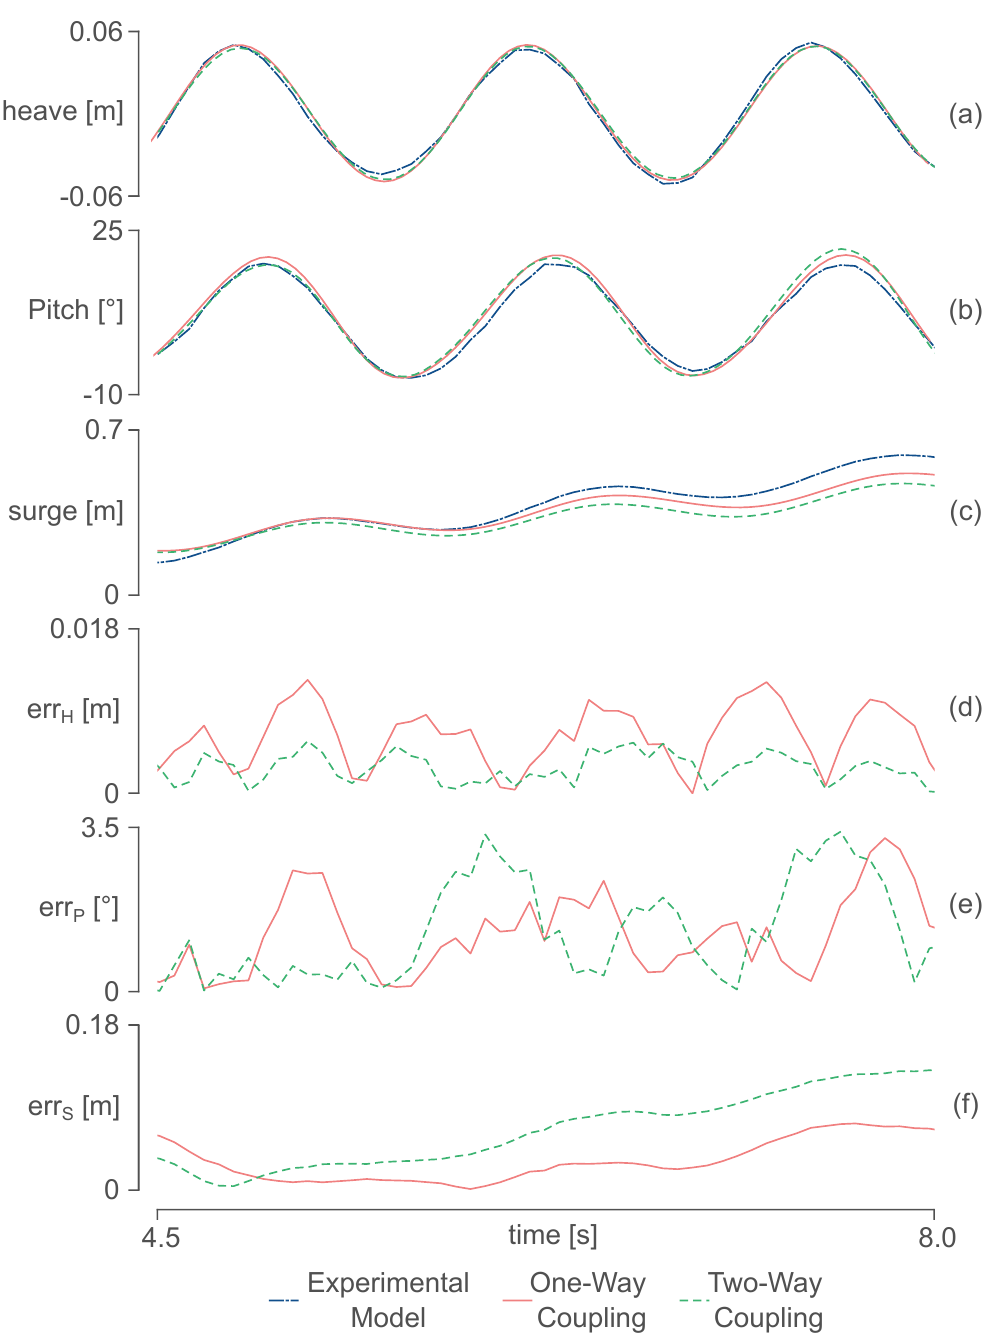
Figure 9. Comparison of time series and error between numerical and experimental results of the three degrees of freedom of the box with heave, pitch and surge motions (top three graphs). The difference between the numerical results and the experimental results is expressed in the error values for heave err H , pitch err P and surge err S (bottom three